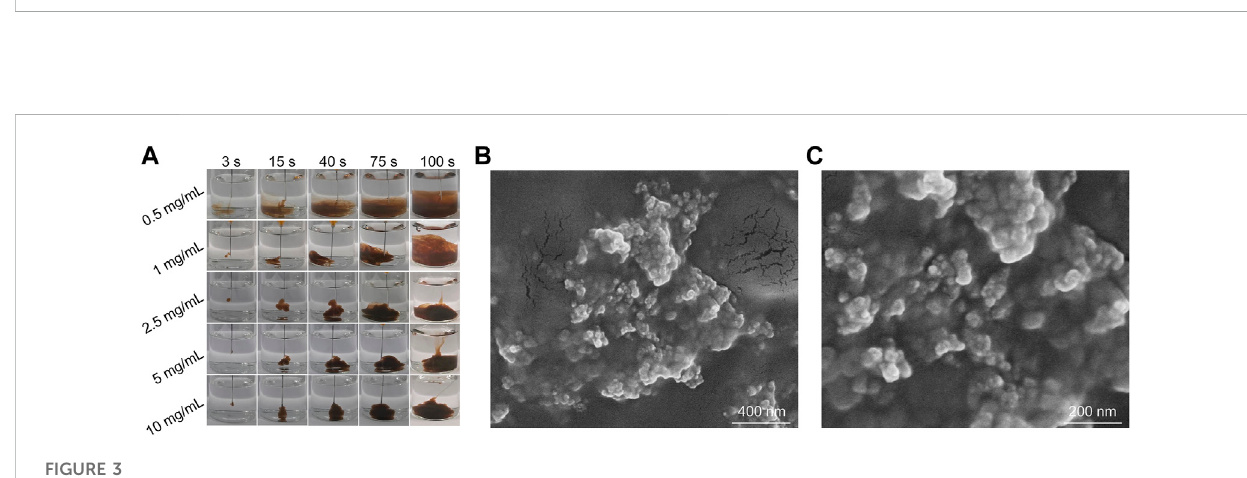
FIGURE 2 Evaluation of photothermal conversion ef fi ciency. (A) Thermal imaging of Fe 3 O 4 nanoparticle solution under 808 nm laser irradiation at power densities of 0.5, 1.0, and 1.5 W/cm 2 . (B) Temperature pro fi les of Fe 3 O 4 nanoparticle solution under different power densities of 808 nm laser irradiation. (C) Thermal imaging of Fe 3 O 4 nanoparticle solutions at concentrations of 100, 200, 350, and 500 μ g/mL under 808 nm laser irradiation at a power density of 1.0 W/cm 2 . (D) Temperature pro fi les of Fe 3 O 4 nanoparticle solutions at different concentrations under 808 nm laser (1.0 W/cm 2 ) irradiation. (E) The photothermal stability evaluation of the Fe 3 O 4 nanoparticle solutions after 5 laser cycles.